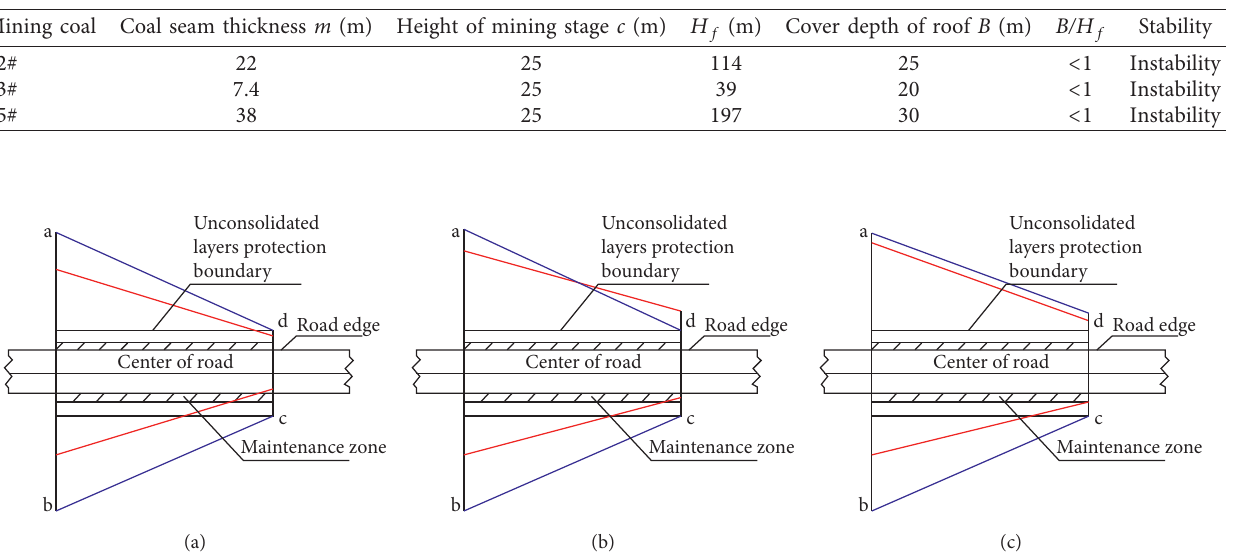
Figure 8: Fracture zone of inclined coal seam. Table 1: Evaluation results of ground stability of goaf.